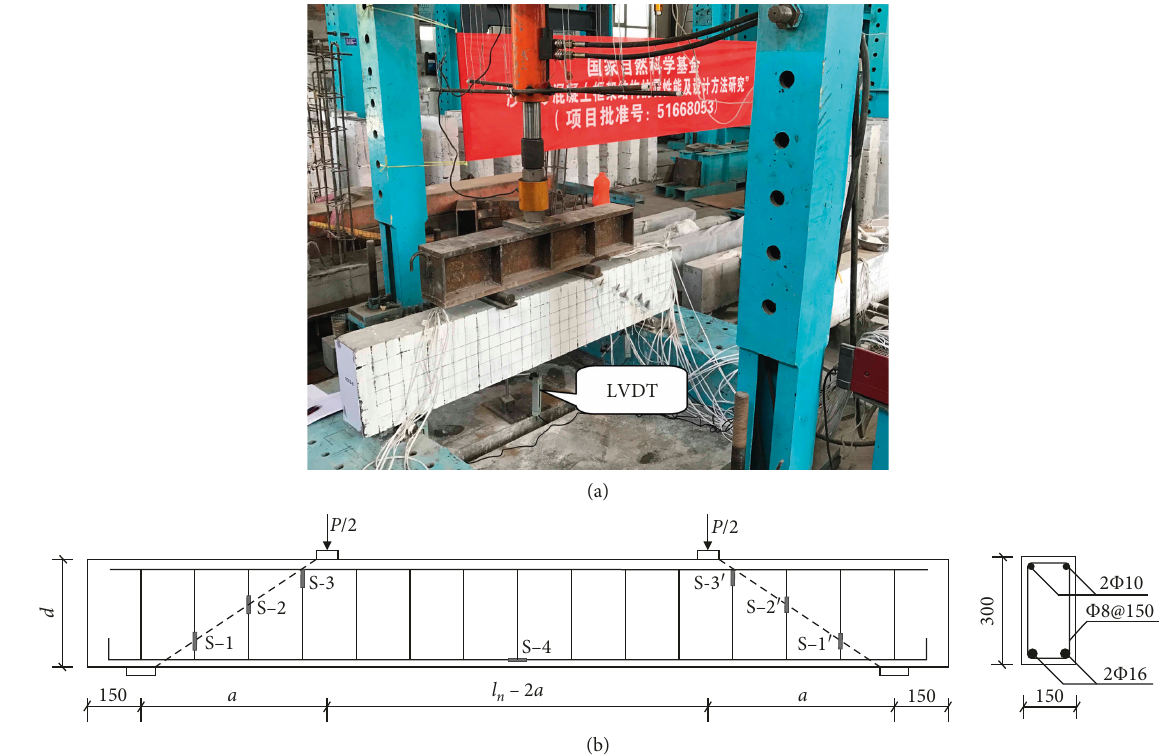
Figure 1: Test setup and details of test beams. (a) Test setup and load pattern. (b) Cross sections, reinforcement layout, and location of strain gauges on the test beams.